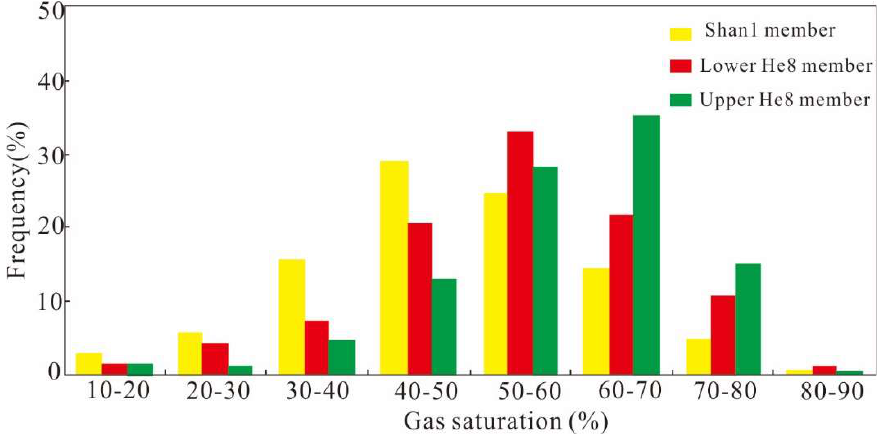
Figure 5. Frequency of gas saturation in Sulige gas field.